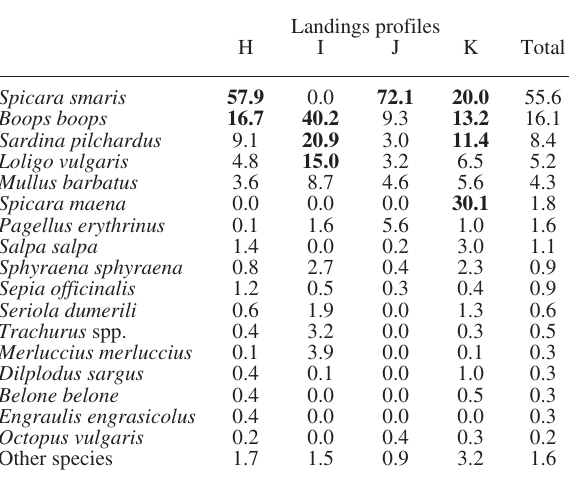
Table 3. – average landings profiles of the four clusters identified in the ionian Sea (Fig. 6), given as the proportion (%) of the landings of each species to the total landings of each cluster. the most important species of each profile (with a proportion in landings >10%) are given in bold.